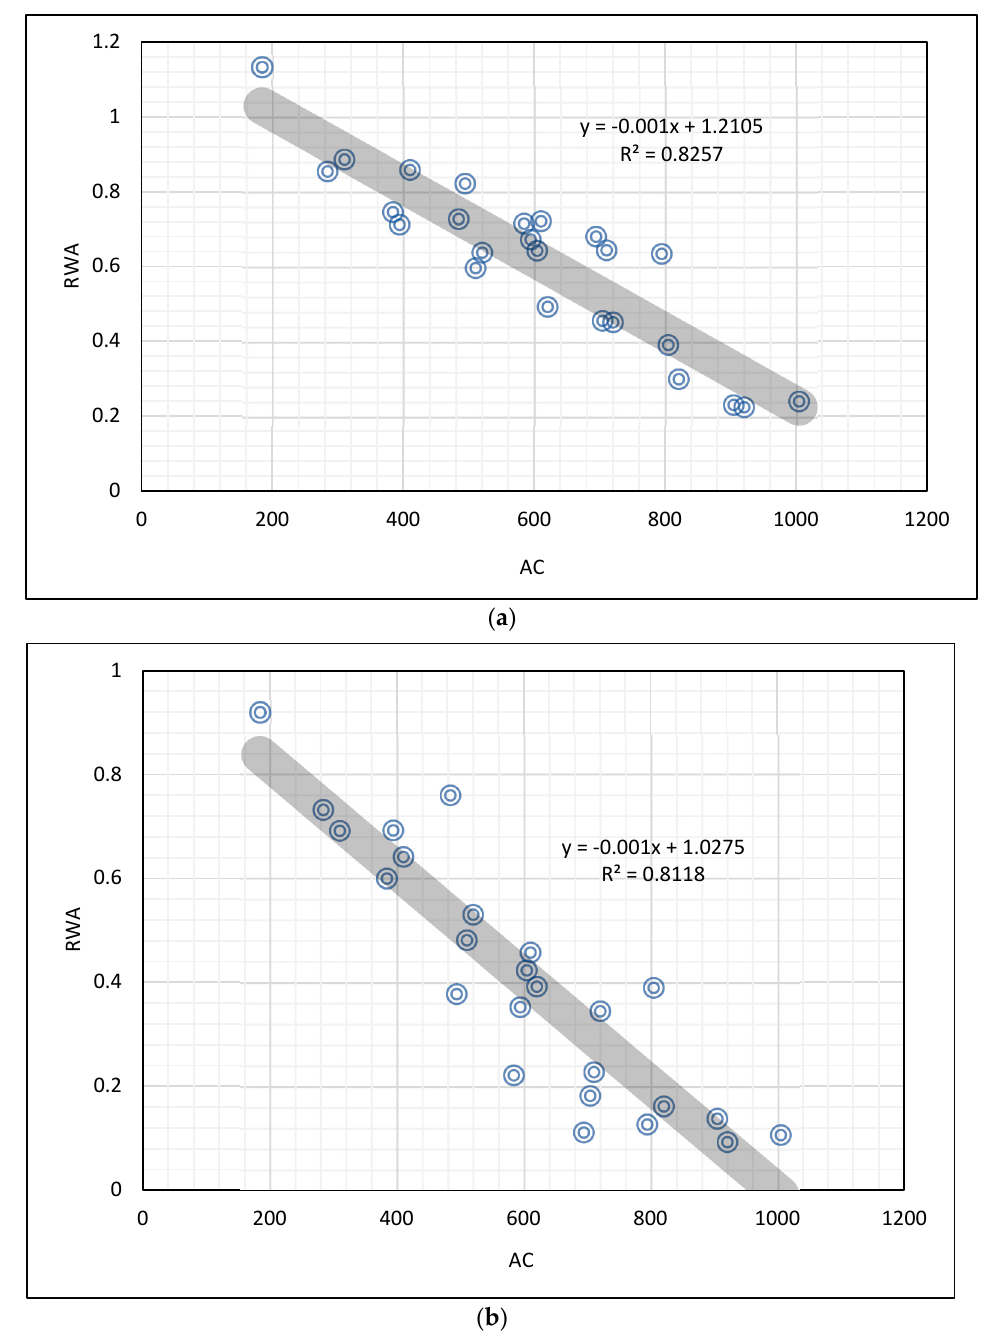
Figure 1. Relative water absorption and Abrasion Coefficient relation for ( a ) RA with 4.0-11.2 mm ( b ) RA with 11.2-22.4 mm.